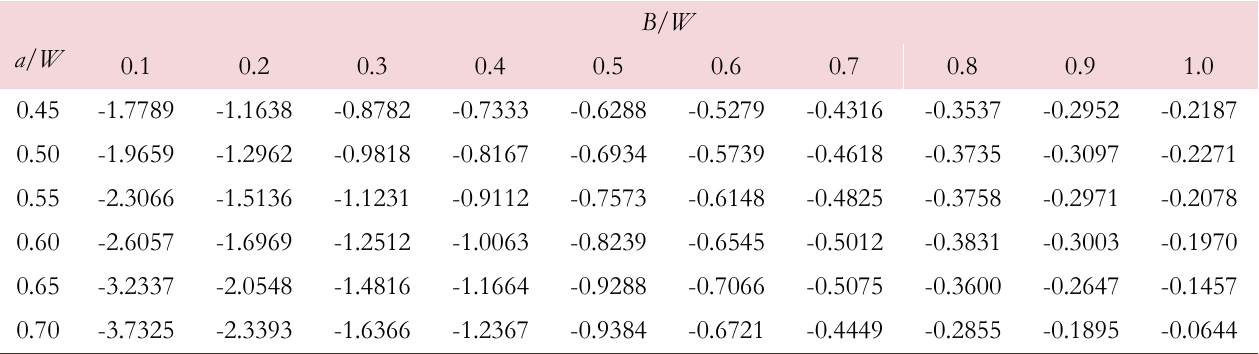
Table 4: Values of C 3 computed from formulations given in